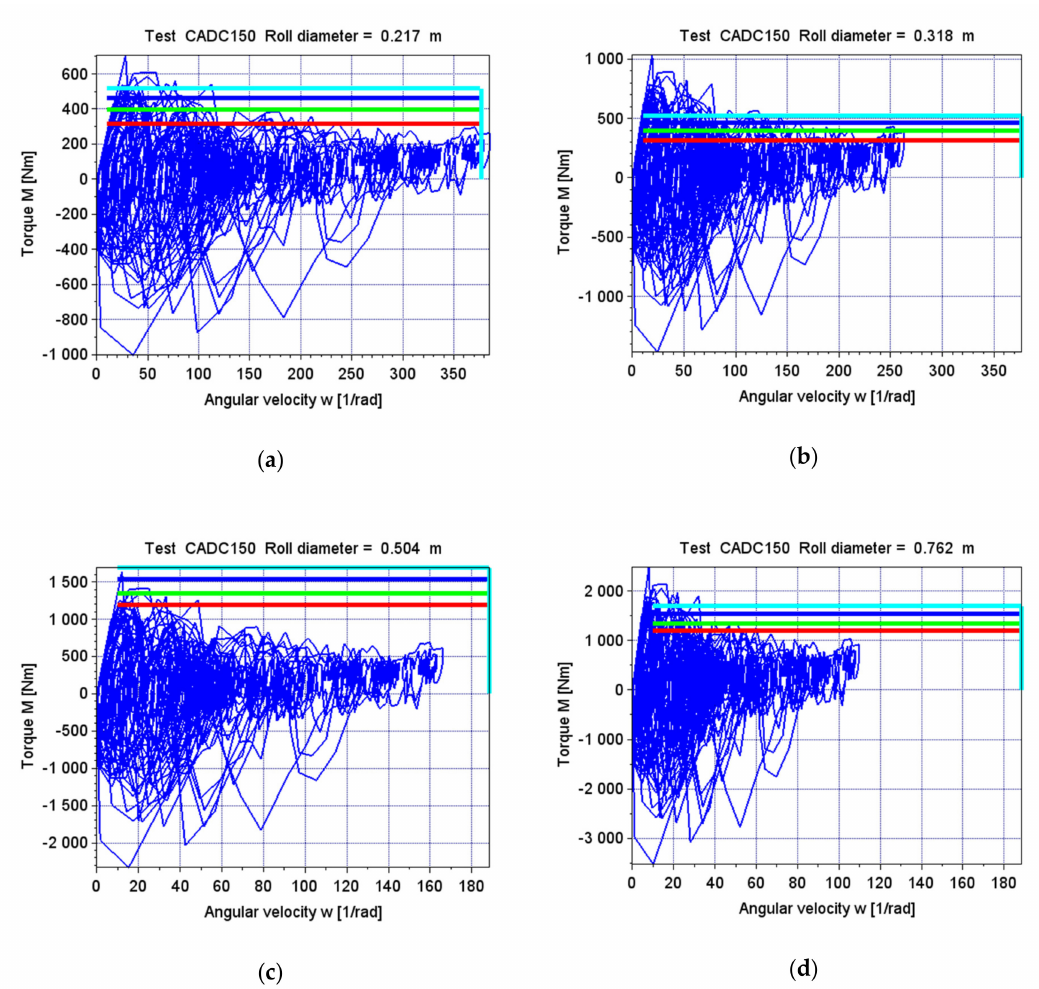
Figure 6. Simulation results for the CADC150 test in the form of rotational speed and torque of the chassis dynamometer brake for changes in the diameter of the brake rollers: ( a ) 0.217 m—ECP 34-1S / 2—Power 120 kVA red line; ECP 34-2S / 2—Power 150 kVA green line; ECP34-1L / 2—Power 174 kVA blue line; ECP 34-2L / 2—Power 196 kVA light blue line; ( b ) 0.318 m—ECP 34-1S / 2—Power 120 kVA red line; ECP 34-2S / 2—Power 150 kVA green line; ECP34-1L / 2—Power 174 kVA blue line; ECP 34-2L / 2—Power 196 kVA light blue line; ( c ) 0.504 m—ECO38 1S4 A—Power 225 kVA red line; ECO38 2S4 A—Power 253 kVA green line; ECO38 3S4 A—Power 289 kVA blue line; ECO38 1L4 A—Power 319 kVA light blue line; ( d ) 0.762 m—ECO38 1S4 A—Power 225 kVA red line; ECO38 2S4 A—Power 253 kVA green line; ECO38 3S4 A—Power 289 kVA blue line; ECO38 1L4 A—Power 319 kVA light blue